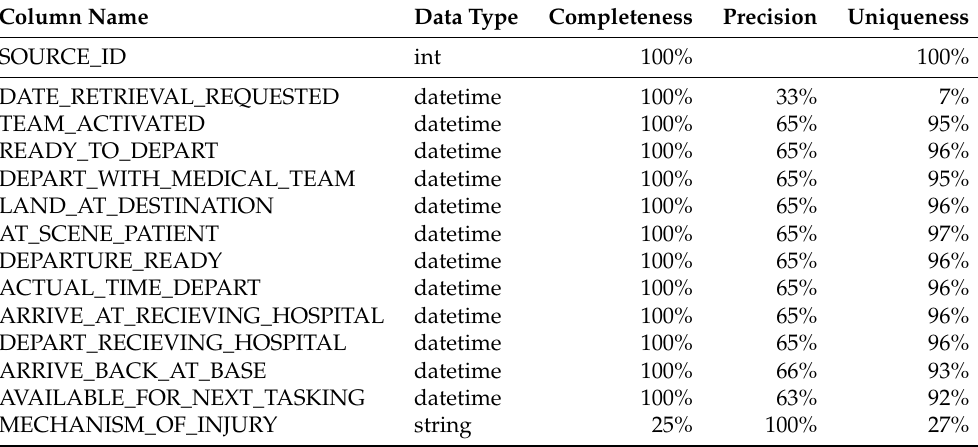
Table 4 provides values for some column-level metrics useful in assessing the quality of the data. Table 4. RSQ—Column-level data quality summary for a sample of